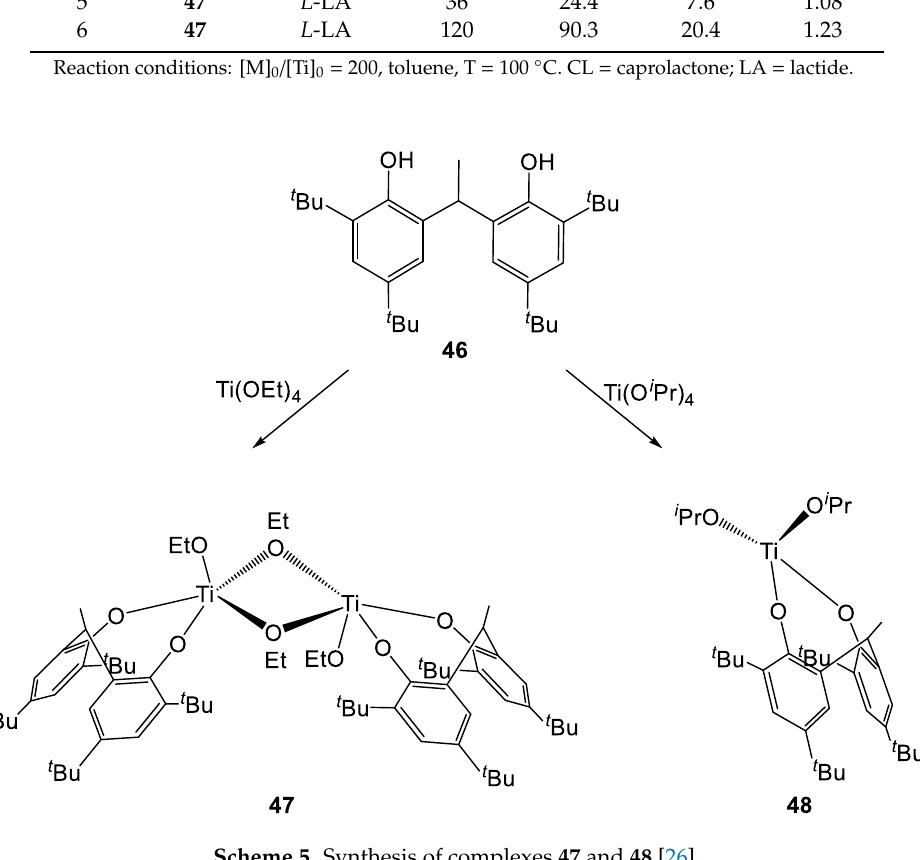
Table 14. ROP of cyclic esters catalyzed by Ti-diphenolate complexes 47 and 48 [26]. Entry Complex Monomer